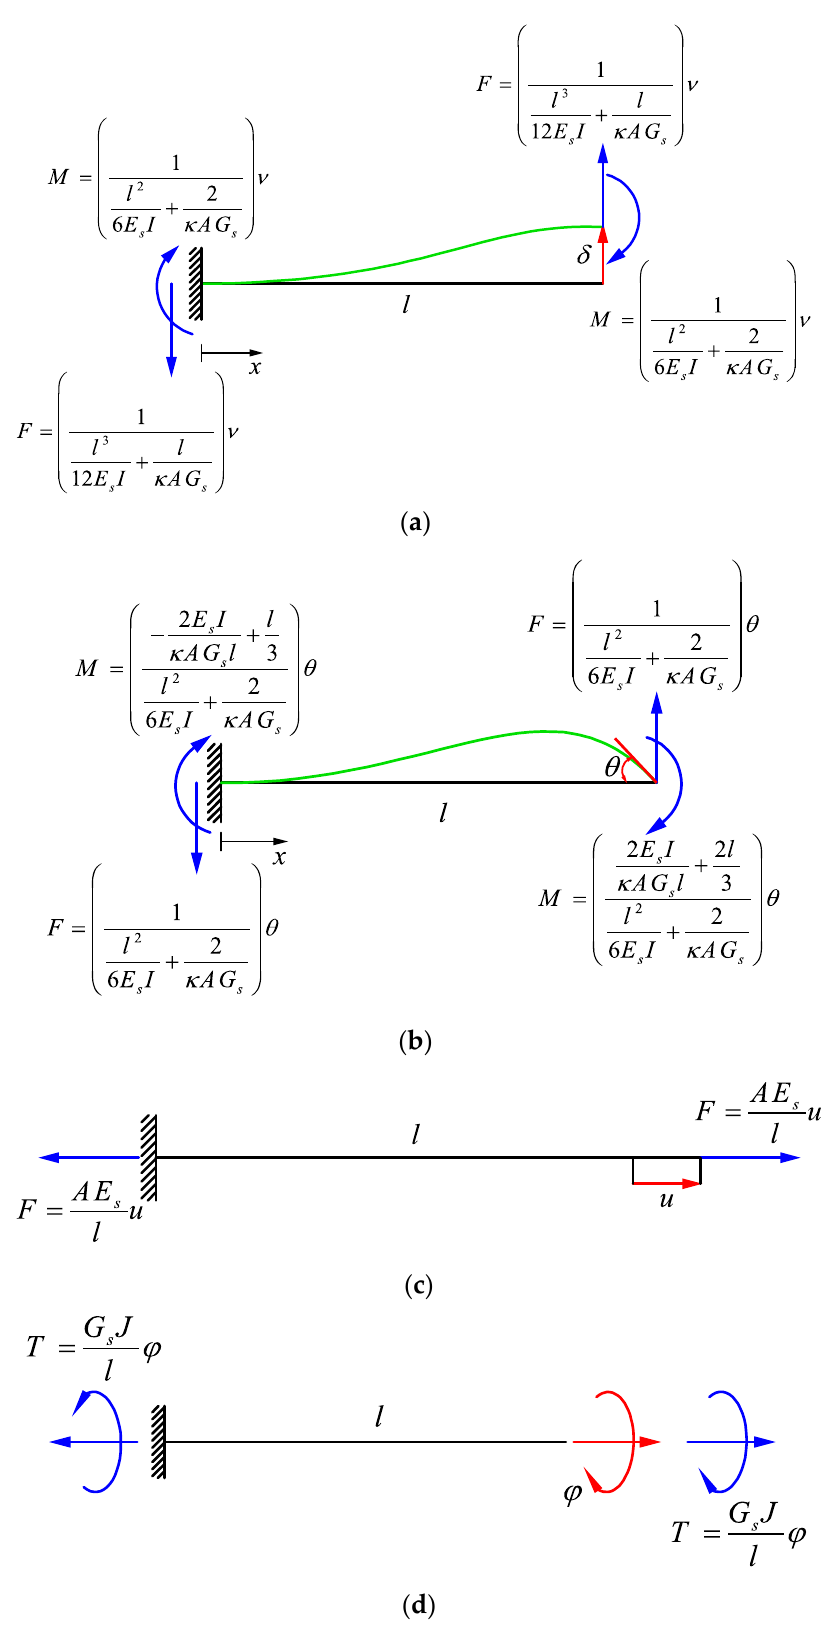
Figure 3. Forces and moments required to cause ( a ) lateral displacement, 𝛿, with no rotation at the free end of the beam, ( b ) rotation, 𝜃, with no lateral displacement at the free end of the beam, ( c ) pure axial extension, and ( d ) pure twist in the free end of a Timoshenko beam.